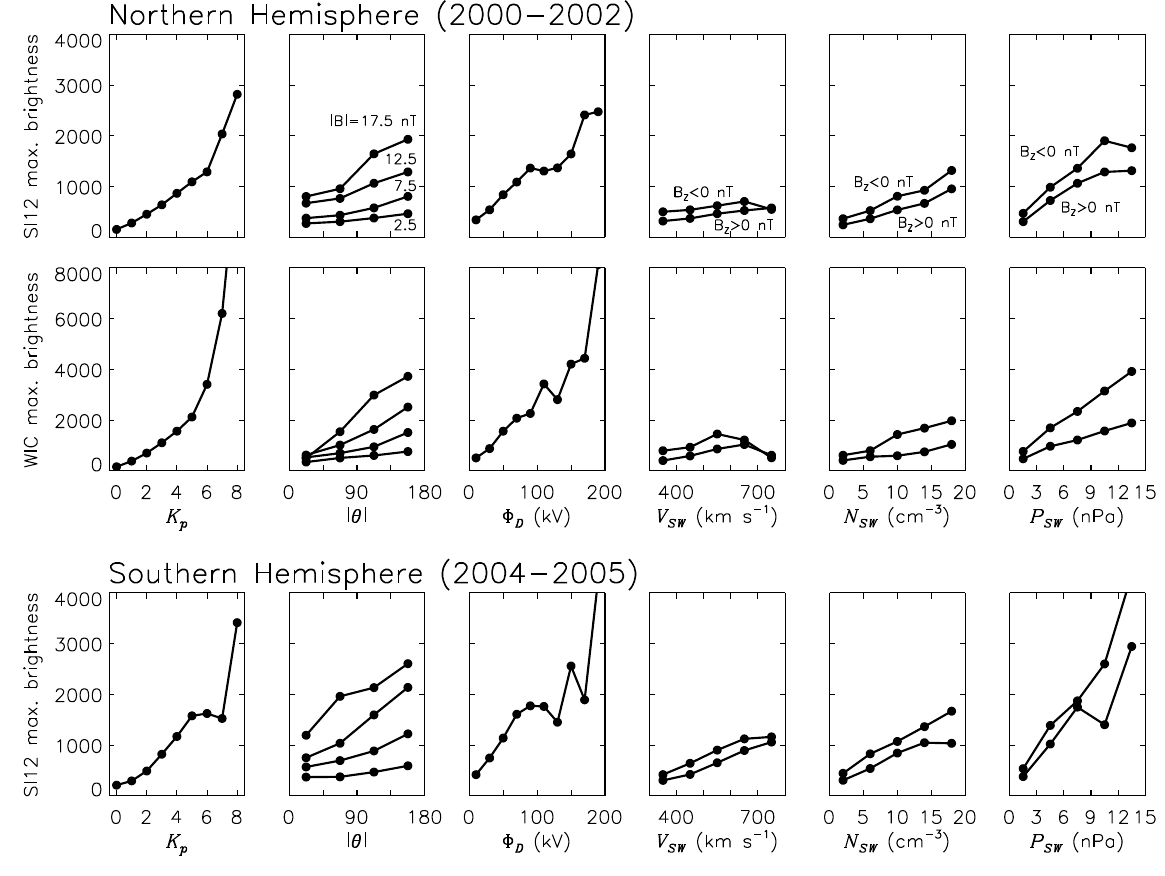
Fig. 4. The variation in the maximum nightside auroral intensity, parameterized by K P , IMF magnitude and clock angle, estimated dayside reconnection rate, solar wind speed, density, and pressure. Upper panels: SI12 observations from the Northern Hemisphere (observing period 2000 to 2002). (Middle panels) WIC observations from the Northern Hemisphere. Bottom panels: SI12 observations from the Southern Hemisphere (observing period 2004 to